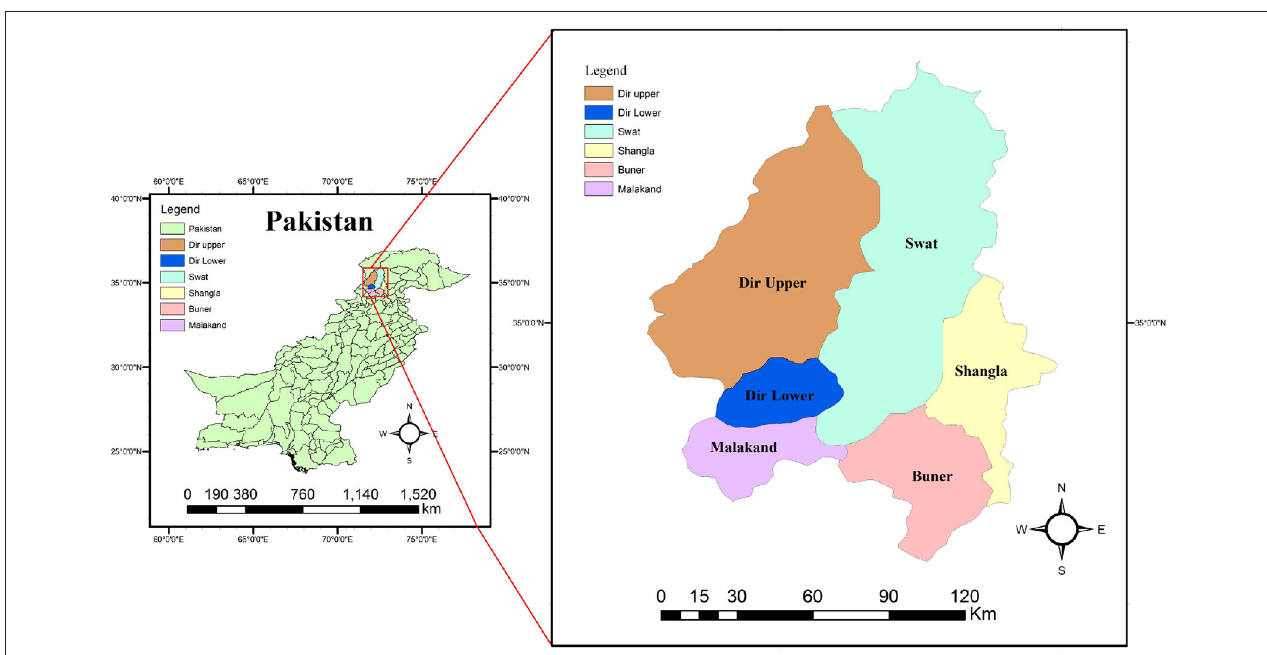
FIGURE 1 | Map of Pakistan showing the study area (Malakand